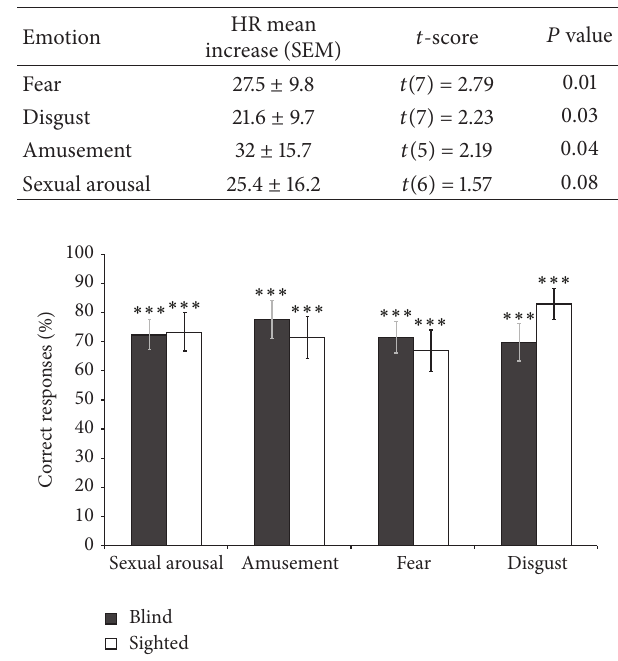
Figure 3: Results of the odour discrimination task. Both groups were significantly above chance level (33%) in detecting emotional chemosensory pads from control pads. Blind participants did not differ from sighted controls. Data present mean ± SD. ∗∗∗ 𝑃 < 0.001 .